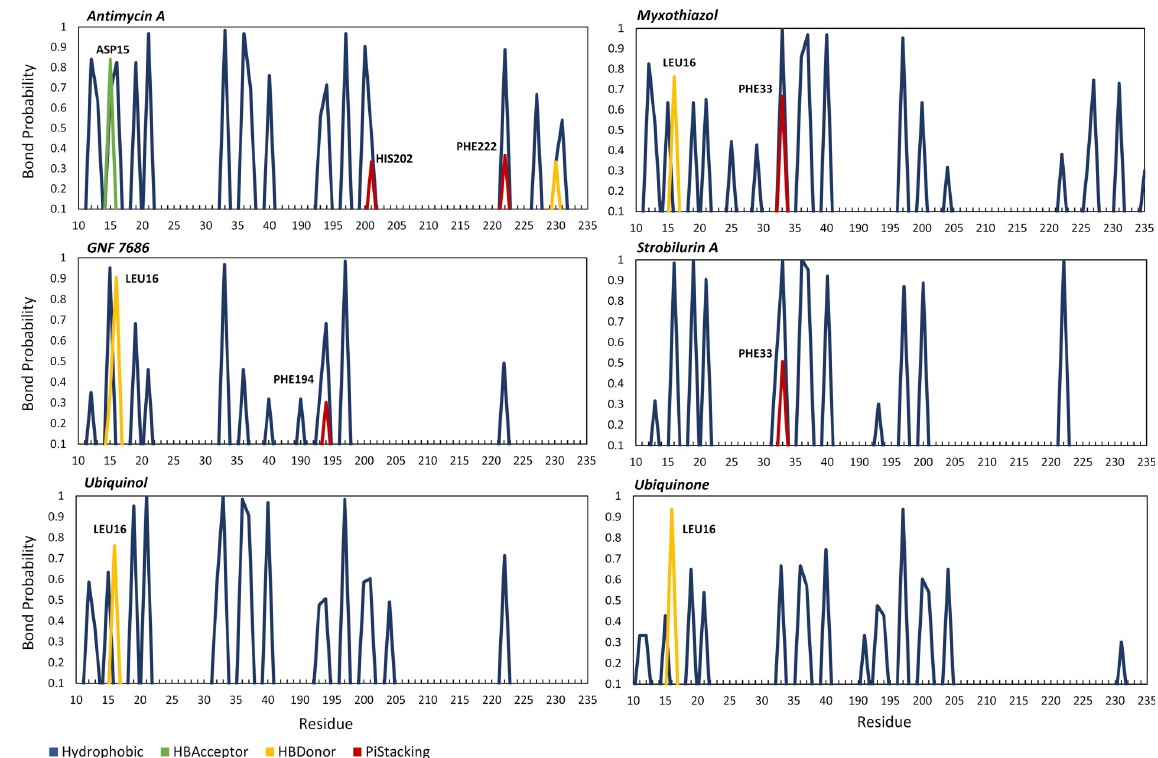
Fig 4. Bond probabilities between each ligand investigated and Qi receptor residues in the ranges F10 to I44 and I190 to F235.